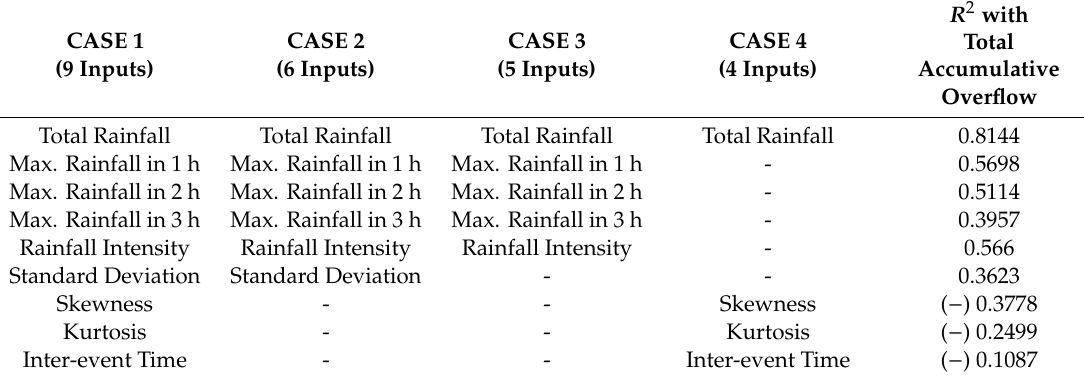
Table 4. Combination of input data.